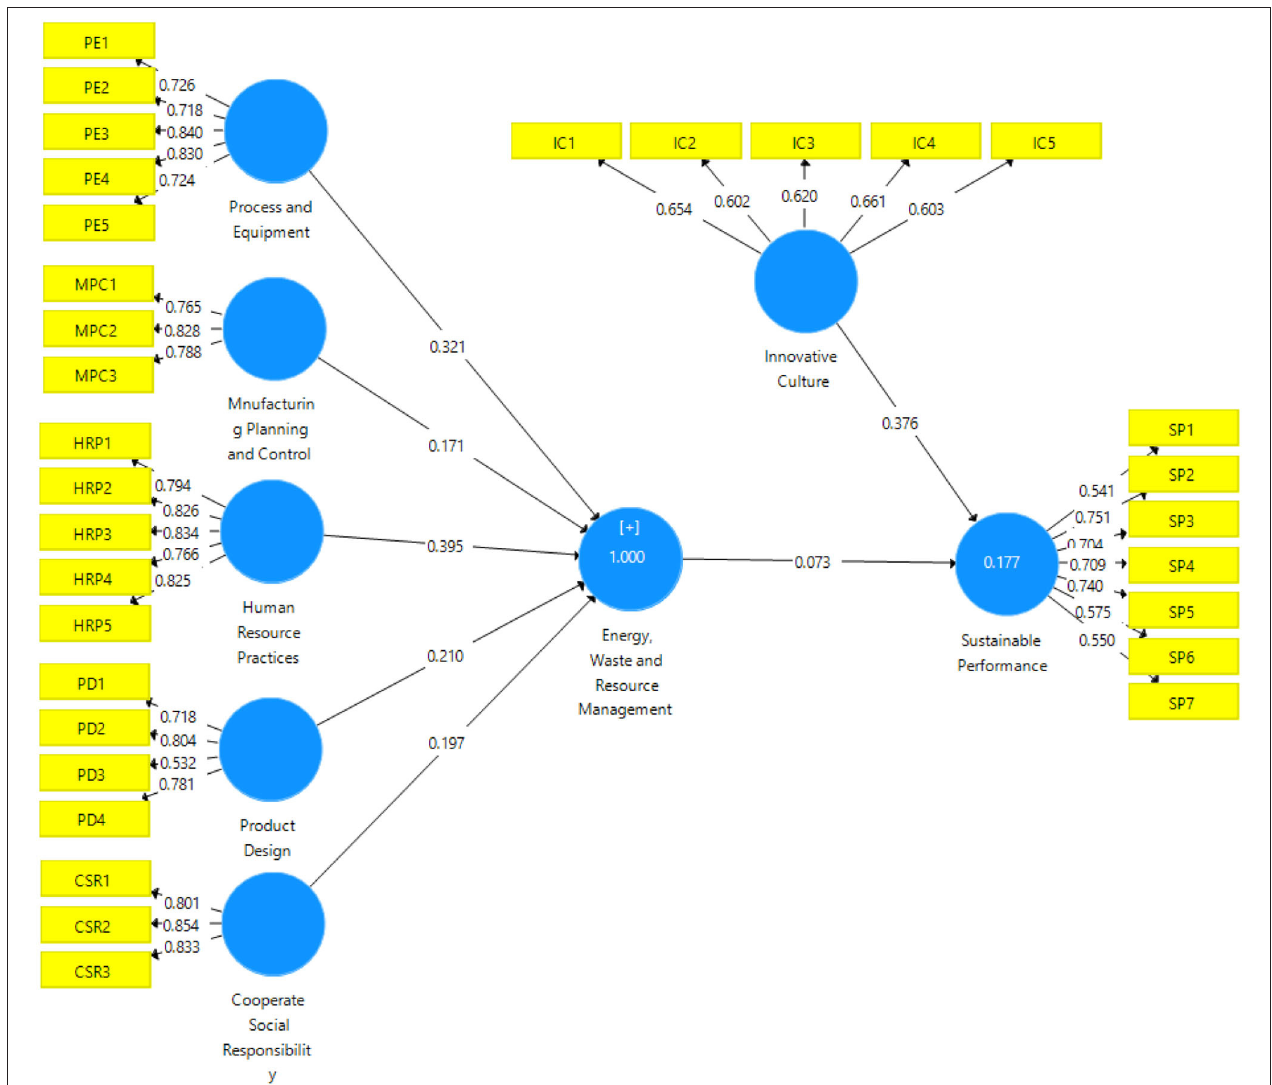
FIGURE 3 | Output of structural model